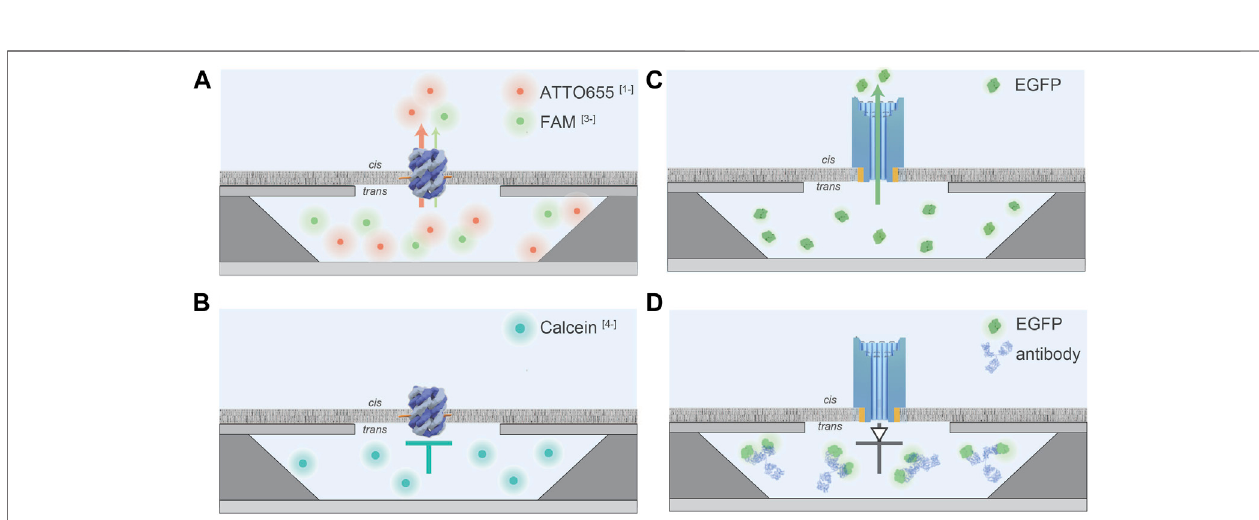
FIGURE4| Schematic illustration of fl ux characteristics ofDNAnanoporesmeasured bythe silicon chip array. Dimensions ofthe silicon chip and ofthenanopores are not drawn in scale. (A) , The co- fl ux experiment of the (-1)-charged ATTO655 (red sphere) and the (-3)-charged FAM (green sphere) through the small six helix DNA nanopore. A faster fl ux of ATTO655 -1 was observed in comparison to FAM -3 . (B) , The (-4)-charged Calcein (blue sphere) cannot fl ux through the small DNA nanopore. (C) , EGFPcan fl uxthroughtheDNA nanofunnel. (D) ,Antibodies against theHis-tag of His6 EGFP canbe used totrap theprotein insidethe nanocon fi nement asthe complex cannot penetrate the pore. This system acts as a molecular diode allowing unidirectional translocation.